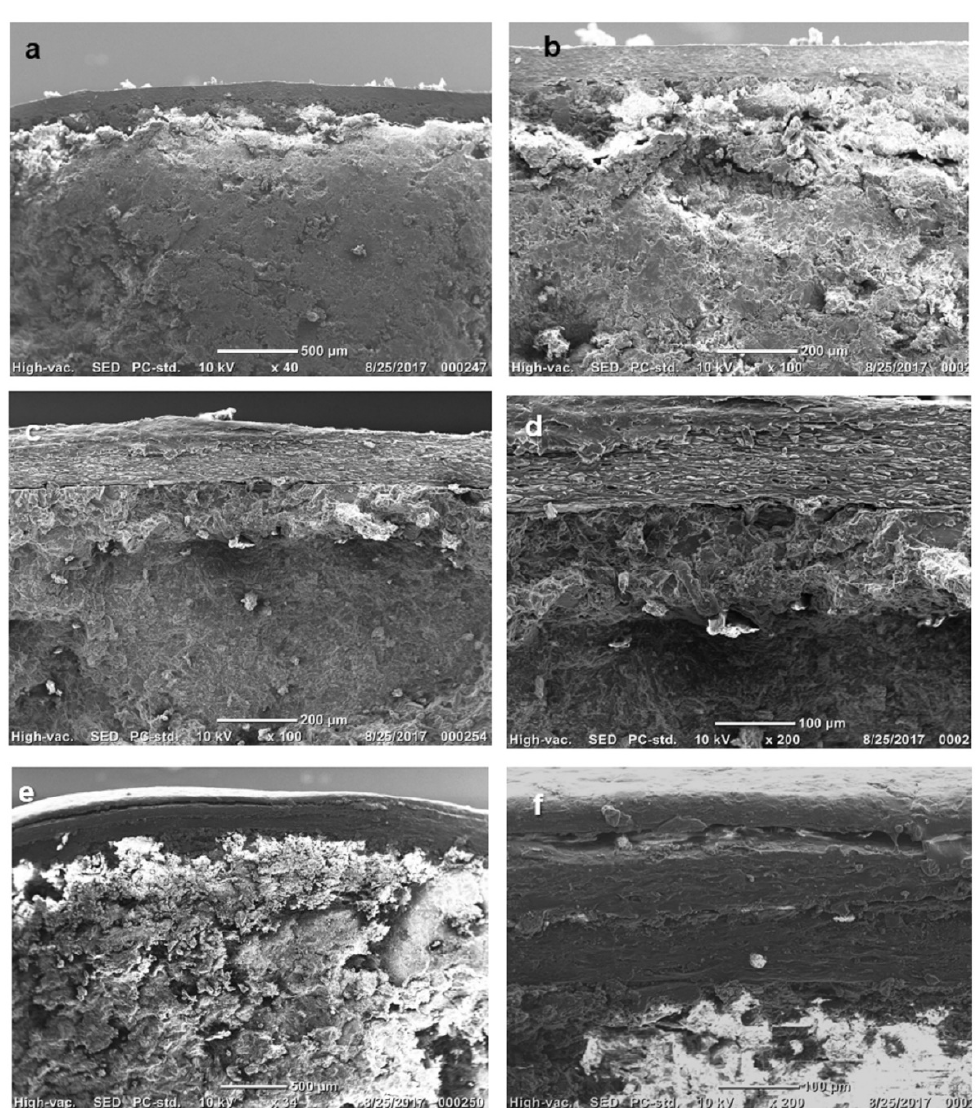
Figure 2. SEM images of cross-sections of Alg-based coating (F2) at ( a ) × 40 and ( b ) × 100 magnifica- tions, Alg based coating overcoated with wax (F3) at ( c ) × 100 and ( d ) × 200 magnifications, ( e ) triple layers of Alg-Wax-Alg (F5) at ( e ) × 34 and ( f ) × 200 magnifications.